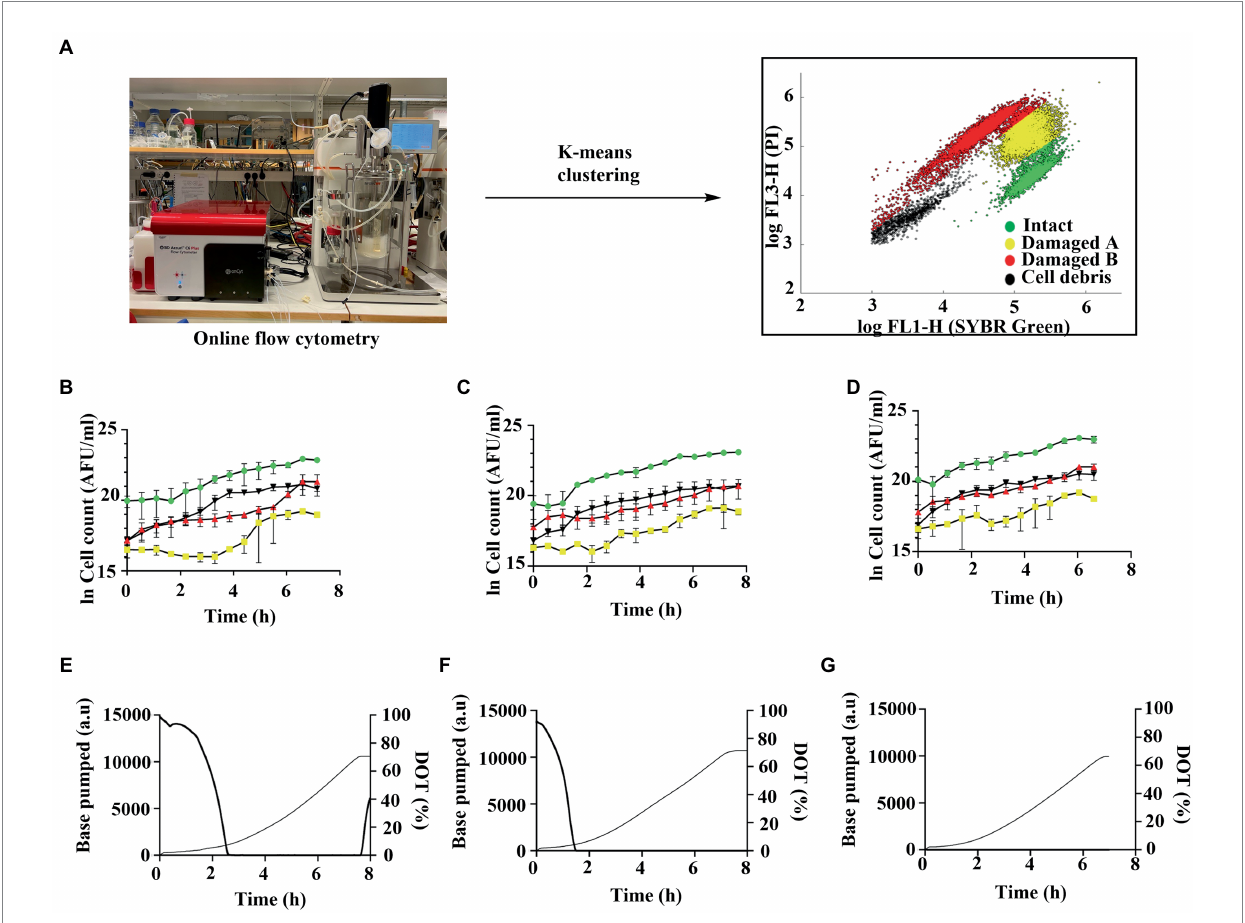
FIGURE 1 (A) Overview of experimental setup for online flow cytometry analysis of batch cultivation of Limosilactobacillus reuteri DSM 17938 in bench scale bioreactors using the OnCyt module connected to a BD Accuri C+ flow cytometer. Cell samples were diluted and stained automatically with SYBR green (FL1-H—533 nm) and propidium iodide (FL3-H—670 nm), enabling the distinction of four subpopulations: live cells (green), damaged cells A (yellow), damaged cells B (red), and cell debris (black). A k -means clustering method was developed for automated data processing and gating of subpopulations. Cell counts of subpopulations during (B) air-sparged, (C) non-sparged and (D) N 2 -sparged cultivations. Representative graph displaying dissolved oxygen tension (DOT%; bold line) and base consumption (thin line) (E) air-sparged, (F) non-sparged and (G) N 2 -sparged cultivations. Data are mean ± SD of three biological replicates for three conditions. AFU, active fluorescent unit; FL,